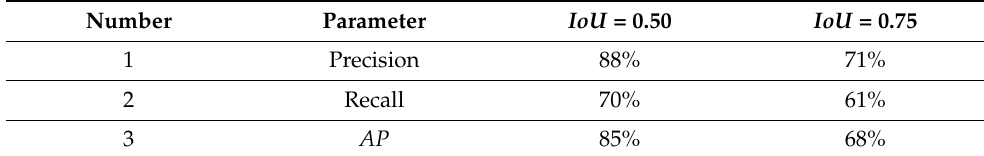
Table 2. Model quality estimates.